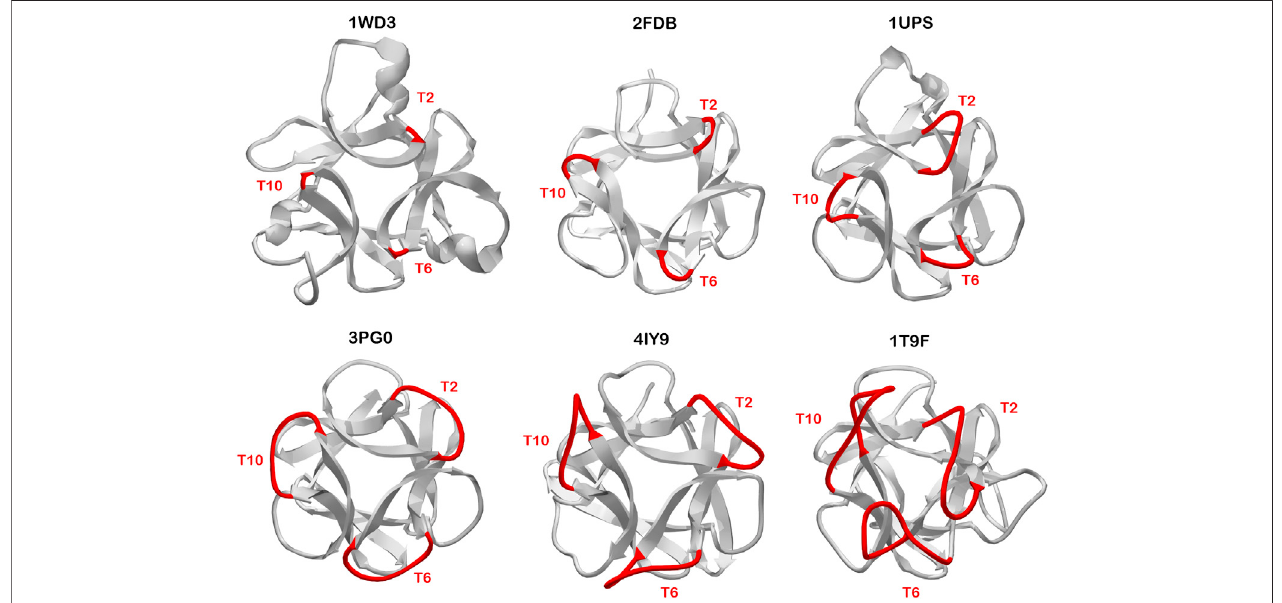
FIGURE7| Examples of β -trefoilproteins having distinct C 3 symmetryattheT2/T6/T10turnregion.TheturnlengthinreferencetotheSymfoilproteinis-1(3PG0), 0 (2FDB), +1 (1UPS), +5 (3PG0), +6 (4IY9), and +8 (1T9F). The view is down the C 3 axis of rotational symmetry. Such symmetric relationships in turn structure suggests divergence of this turn structure occurred prior to duplication/fusion/truncation events leading to the extant β -trefoil architecture.